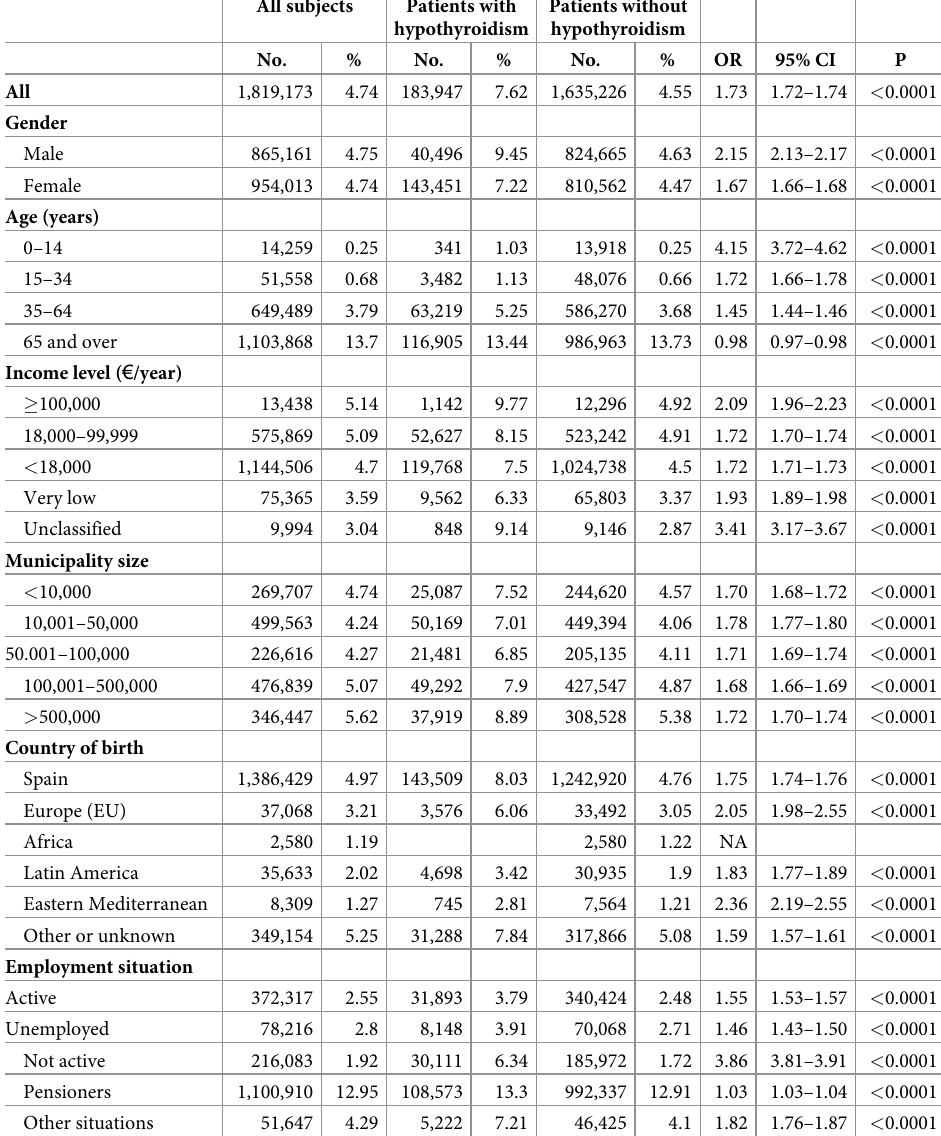
Table 2. Prevalence of cancer in the entire cohort of studied subjects and in patients with and without hypothy- roidism, classified by various demographic variables. All subjects Patients with Patients without hypothyroidism hypothyroidism